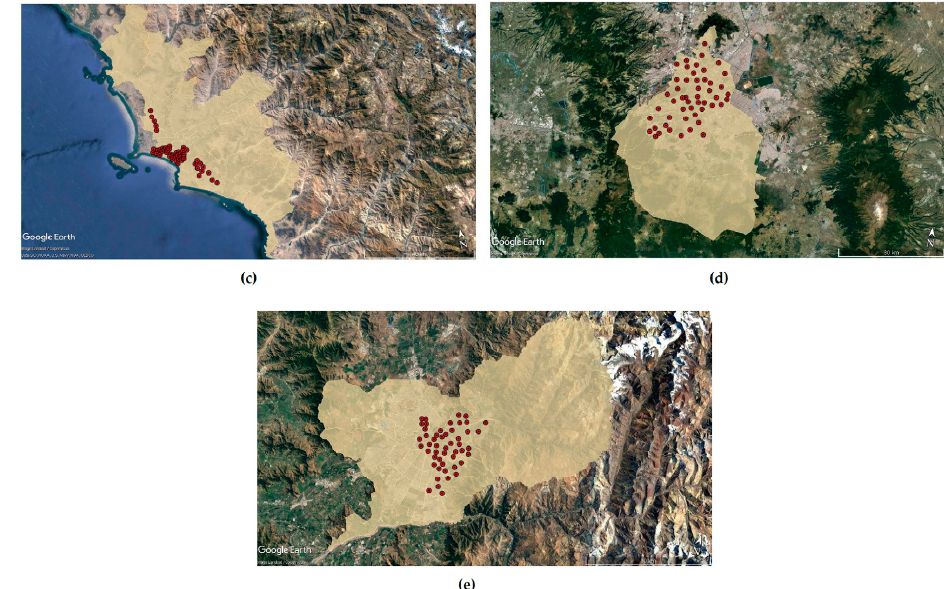
Figure 1. 250 sampled polygons distributed within five megacities. ( a ) Bogota; ( b ) Buenos Aires; ( c ) Lima; ( d ) México City; ( e ) Santiago. Image Landsat/Copernicus downloaded Google Earth.